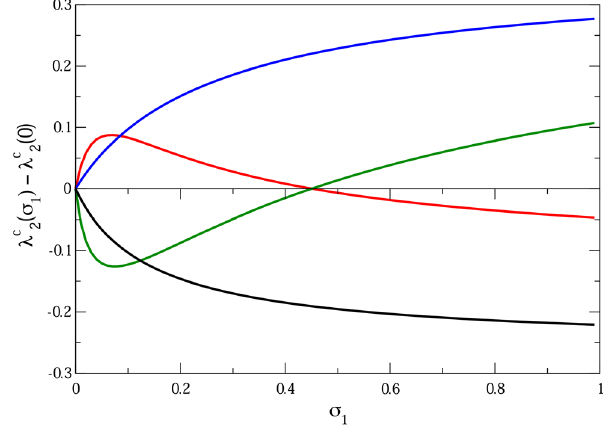
FIG. 9. Relative variation of epidemic threshold of disease 2 as a function of σ 1 for different parameter sets. Black line: Coherent enhancement of disease 1 over disease 2: λ 1 ¼ 0 . 2 , μ line: Coherent impairment of disease 1 over disease 2: λ 1 ¼ 0 . 2 , μ